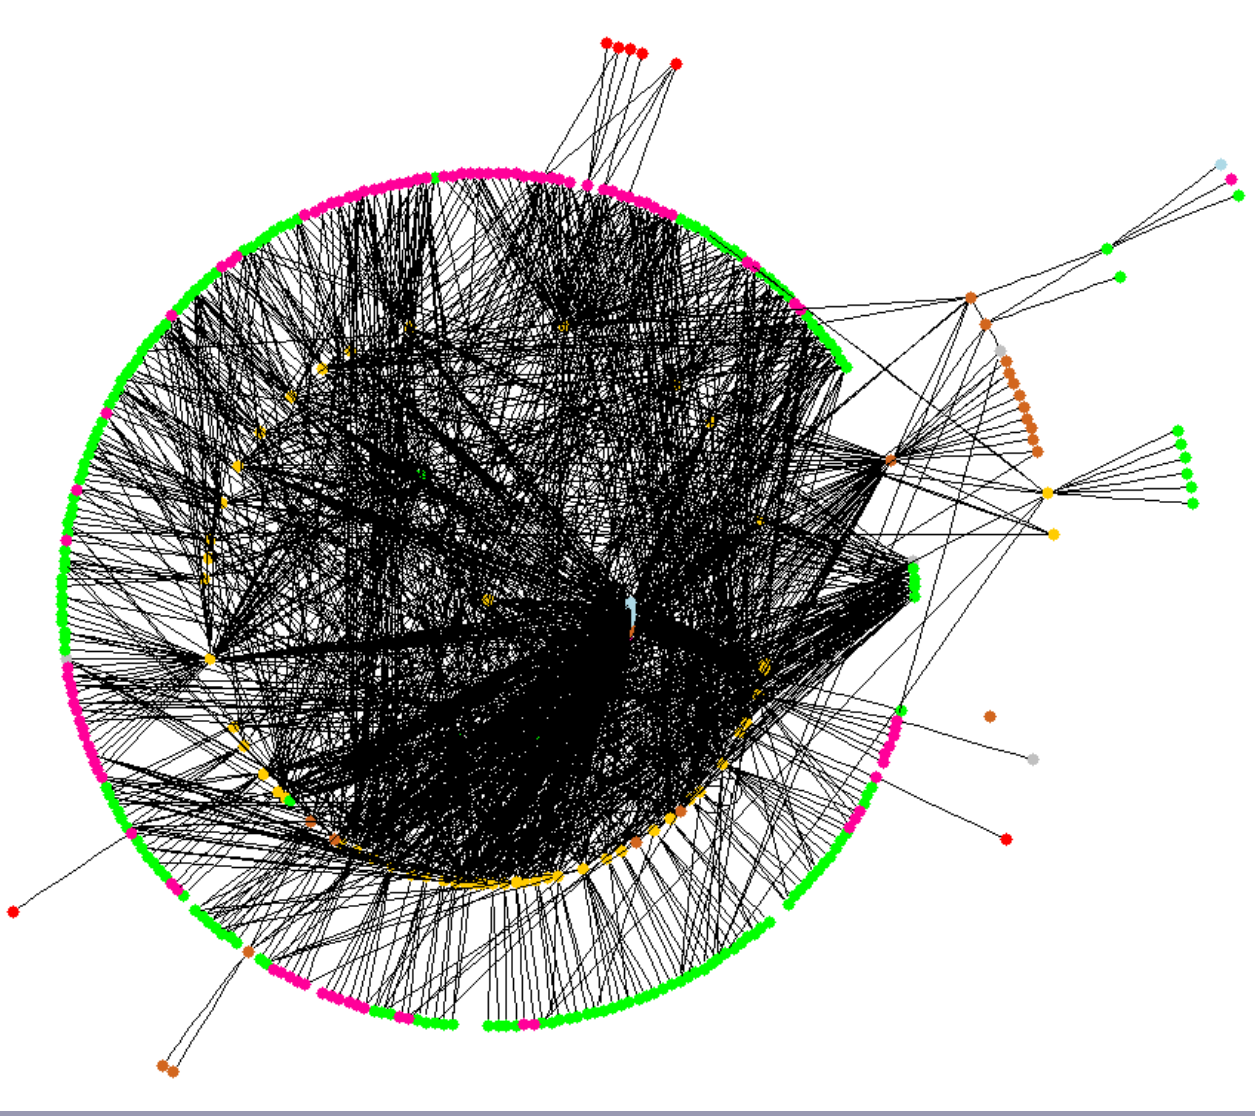
Fig. 1. The food web of 58 species of rangeland grasshoppers in Wyoming. Each node represents a single species or a set of closely related species. The yellow represents grasshoppers, blue represents birds, tan represents mammals, purple represents pathogens, pink represents insects, nematodes, and spiders (parasites, parasitoids, and predators), red represents hyperparasites, and green represents plants. Gray nodes represent non-living material including leaf litter, dung, and dead arthropods. Although the food web is a directed graph, we omit the arrows signifying direction in the figure due to the density of edges. Note that there are loops present in the figure where cannibalism occurs (which is distiguished from necrophagy, represented in the gray nodes). This food web is necessarily incomplete as only links found in primary literature have been included (Peterson 1955, Lavigne and Pfadt 1966, Banfield 1974, Bekoff 1977, Ritchie 1978, LaChapelle et al. 1984, Pierce and Peek 1984, Arjo and Pletscher 1999, Pfadt